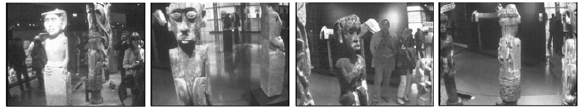
Figure 12: Objects’ citation at Quai Branly Museum provided by the visitors during the